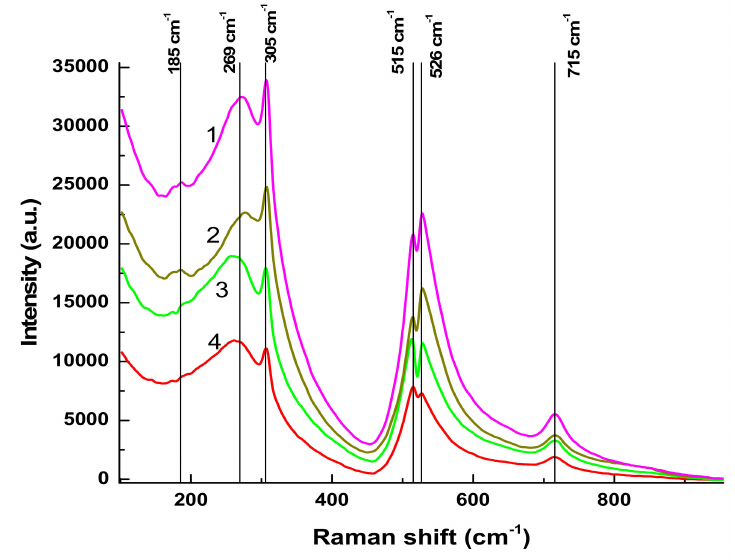
Figure 3. Raman spectra of BTO NPs obtained at various pulse durations. (1)—BaTiO 3 in H 2 O, 1 ps; (2)—BaTiO 3 in H 2 O 2 , 1 ps; (3)—BaTiO 3 , ablation time of 45 min at 170 fs in H 2 O; (4)—BaTiO 3 ablation time of 45 min at 170 fs in H 2 O 2 . Excitation wavelength is of 473